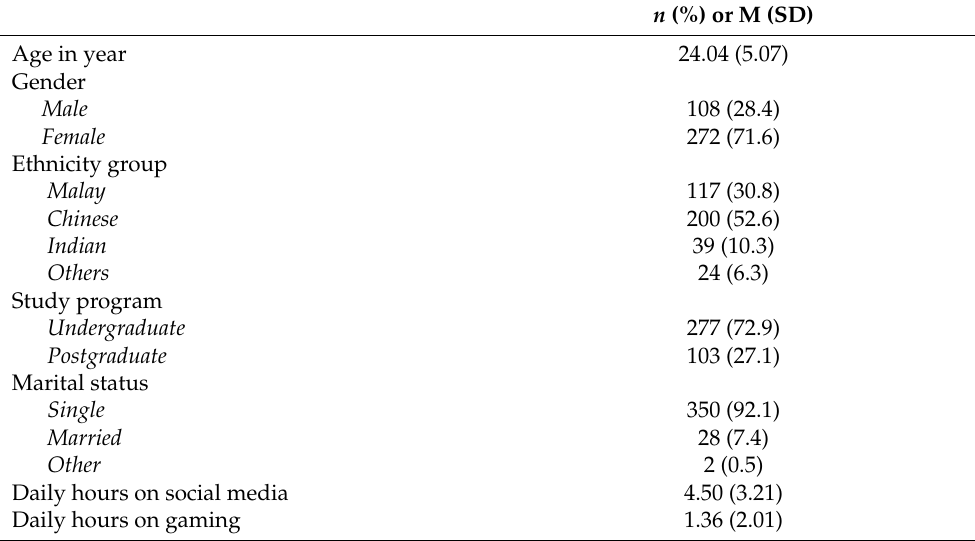
Table 1. Characteristics of the participants ( N =